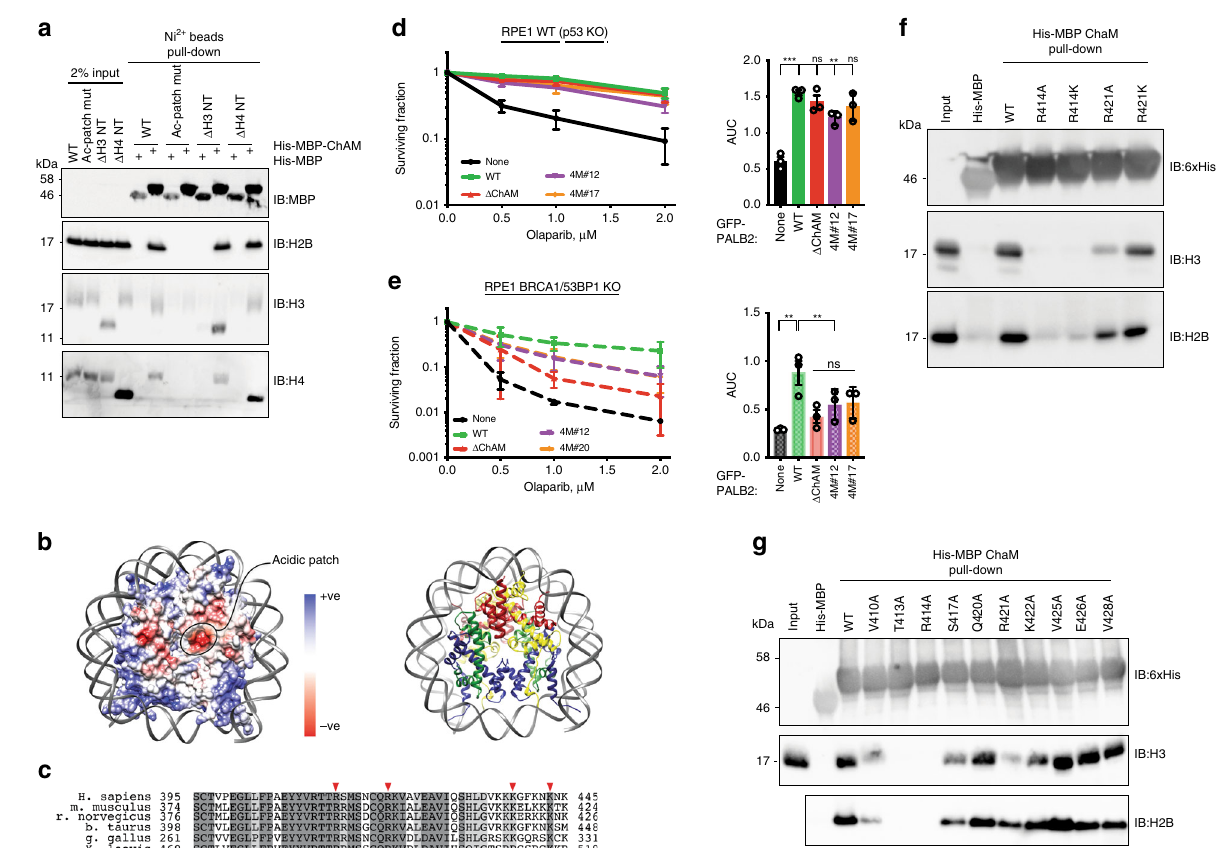
Fig. 4 ChAM domain of PALB2 interacts with nucleosome acidic patch. a In vitro pull-down (PD) assay using puri fi ed components. 6xHis-MBP-tagged PALB2 ChAM domain or 6xHis-MBP immobilised on Ni-NTA af fi nity beads, incubated with recombinant nucleosome variants. Acidic patch mutant (Ac- patch mut) comprises H2A E61/91/92A and H2B E105A; Δ H3 NT comprises H3 residues 25 − 135; Δ H4 NT comprises H4 residues 21 − 106. Anti-H3 and H4 antibodies showed increased reactivity towards histones with shorter N-terminal tails. b The nucleosome and its acidic patch. Left panel: electrostatic potential view of the protein histone surface; right panel: ribbon representation of the nucleosome core particle. c Sequence alignment of ChAM with alanine scanning mutation areas highlighted (blue line) and basic residues mutated in 4 M mutant highlighted (red arrows). d , e Clonogenic survivals of RPE1 p53 KO ( e ) or p53/BRCA1/53BP1 KO ( f ) cells complemented with PALB2 WT , PALB2 Δ ChAM or PALB2 4M in response to indicated doses of olaparib. Lower panels show corresponding area under curve (AUC) bar graphs; n ≥ 3. The bars represent mean ± s.e.m.; one-way ANOVA; ** P < 0.01, *** P < 0.001; ns, not signi fi cant ( P ≥ 0.05); n = 3 independent experiments. Source data are provided as a Source Data fi le. f Pull-down assays comparing NCP association of 6xHis-MBP-PALB2 ChAM variants with charge removal and charge retaining ChAM mutations on Arg414 and Arg421. g Pull-down assays between NCPs and immobilised 6xHis-MBP-ChAM variants containing alanine mutations across the proposed nucleosome-interacting